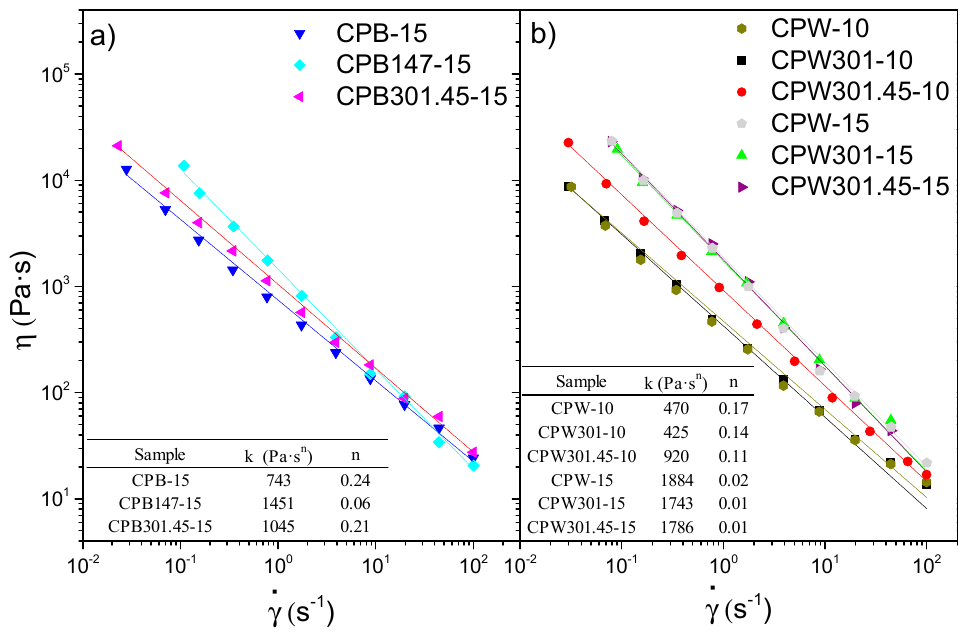
Figure 5. Viscous flow curves of polyurethane oleogels prepared with ( a ) barley- and ( b ) wheat-straw-derived cellulose pulps. Values of the consistency and flow indexes are also included as an inset.